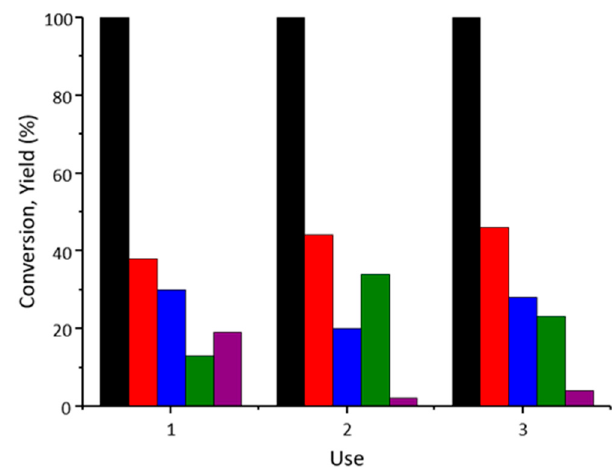
Figure 5. Reusability tests performed over NYL + TiO 2 + AuPd composite membranes. Operative conditions: 4 h, temperature 90 °C, O 2 pressure 10 bar, 25 mL water, HMF concentration 18 mM,